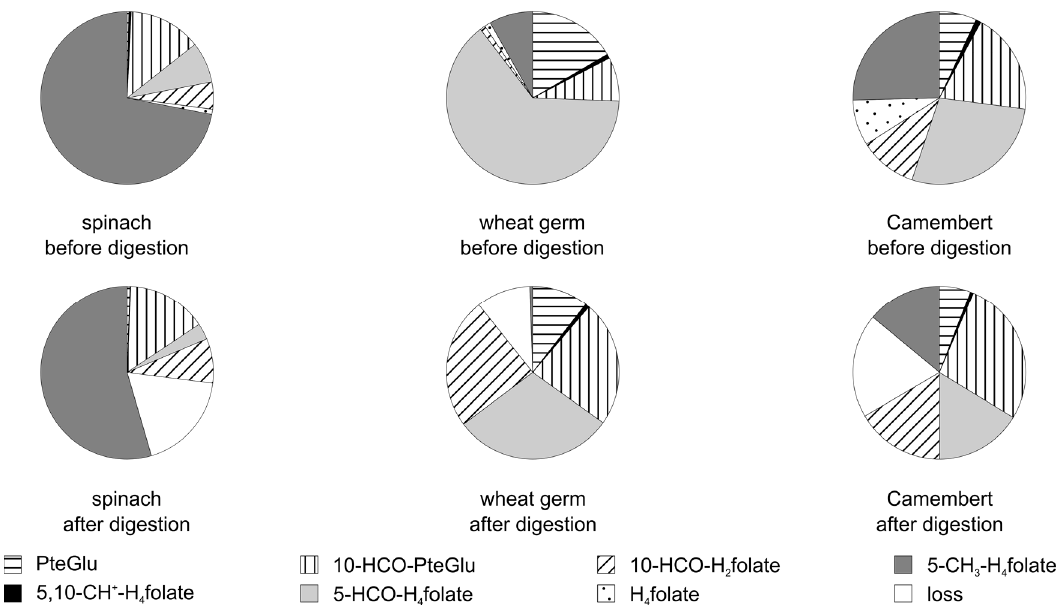
Figure 6. Folate distribution of different foodstuffs before and after the simulated digestion.